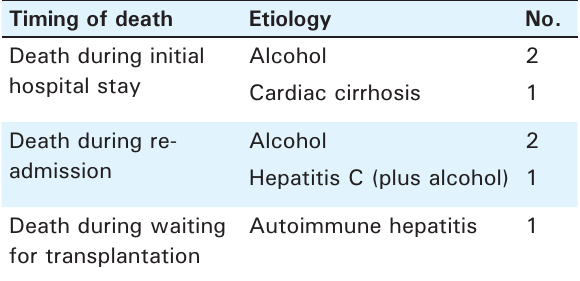
were A, seven were B and remaining 14 patients were C. Outcome of the patients are given in table